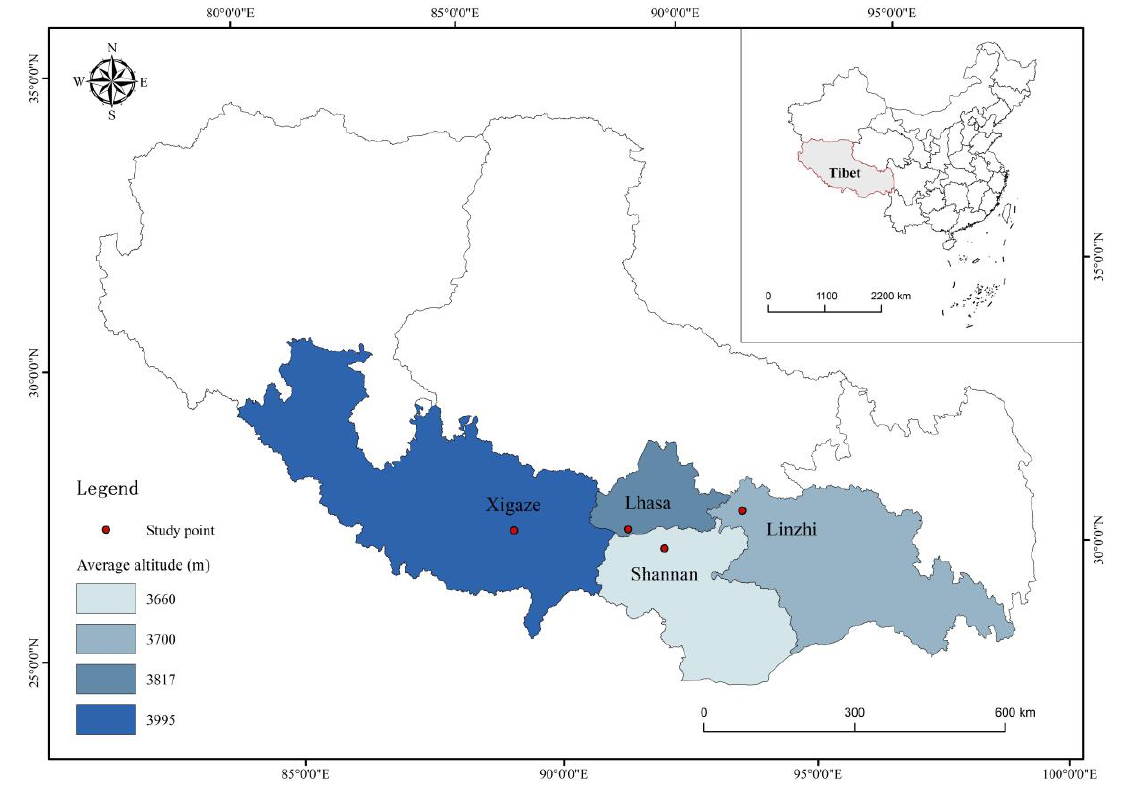
Table 1. Region information of Tibetan chicken samples.